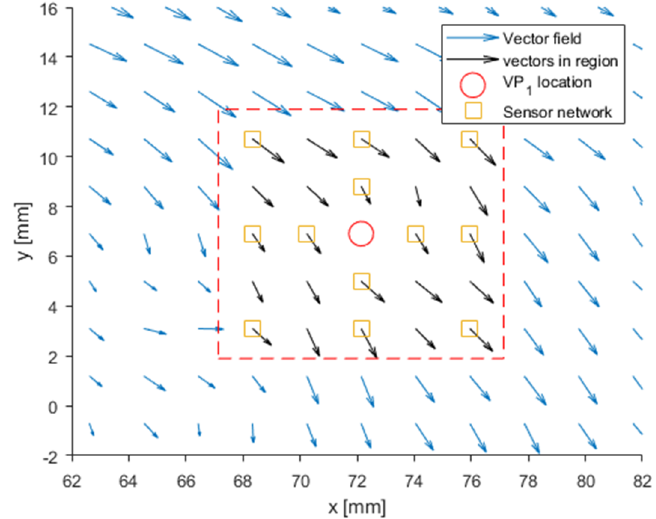
Figure 7. Sensor network and region surrounding VP 1 . Region highlighted represents 10 mm × 10 mm around VP 1 with eligible vectors presented (black). Those used as sensors are indicated (squares).